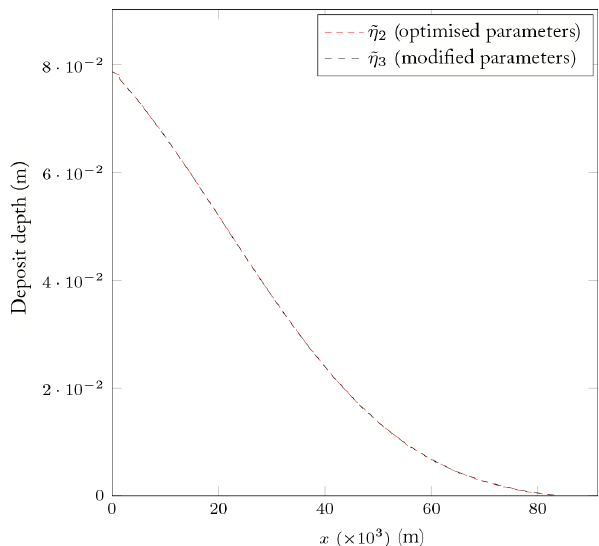
Figure 11. Optimised dimensional deposit output from the model with both mud and sand sediment classes, e η 2 , shown against the results from the same model with the same parameters but a mud- settling velocity reduced by 2 orders of magnitude, e η 3